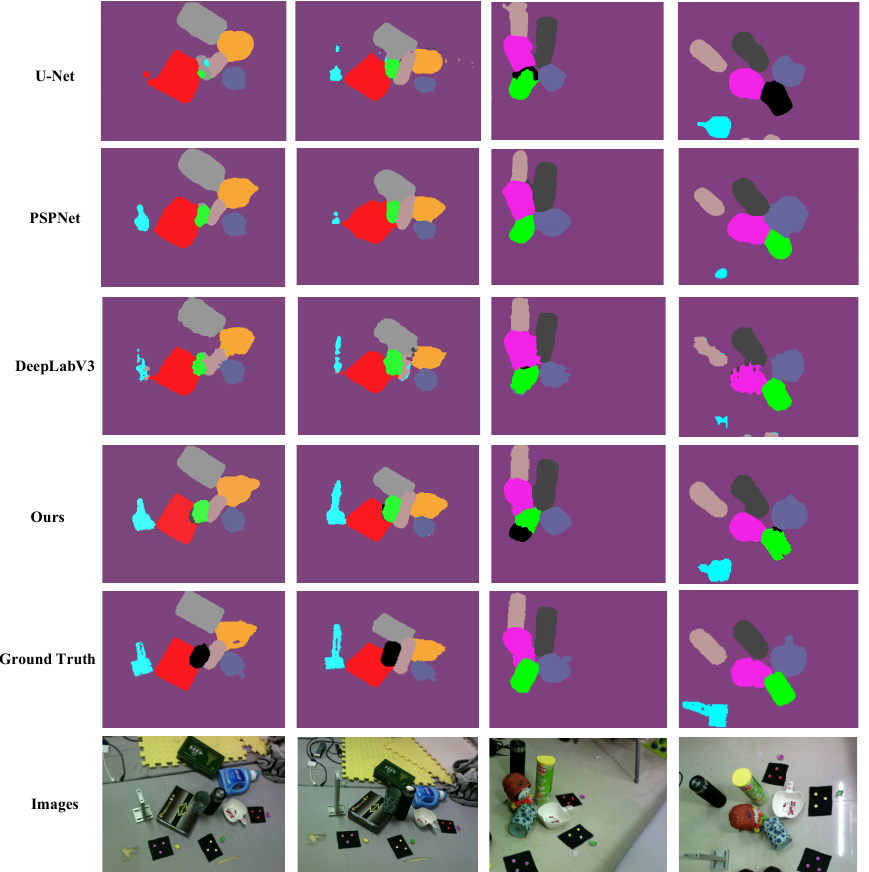
Figure 11. Some qualitative results of our segmentation network and other state-of-the-art segmenta- tion networks. Different colors represent different categories. Table 2. Quantitative evaluation of 6D pose on SIAT